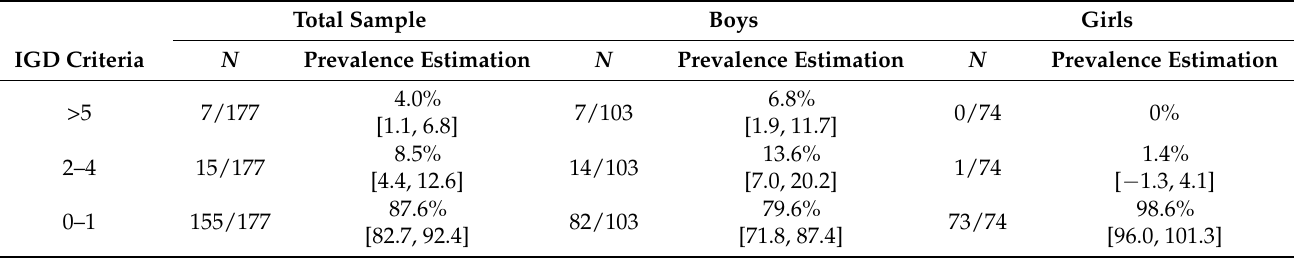
Table 1. Estimated Internet Gaming Disorder (IGD) prevalence in 11- to 17-year-old patients in outpatient psychotherapy assessed via self-report.